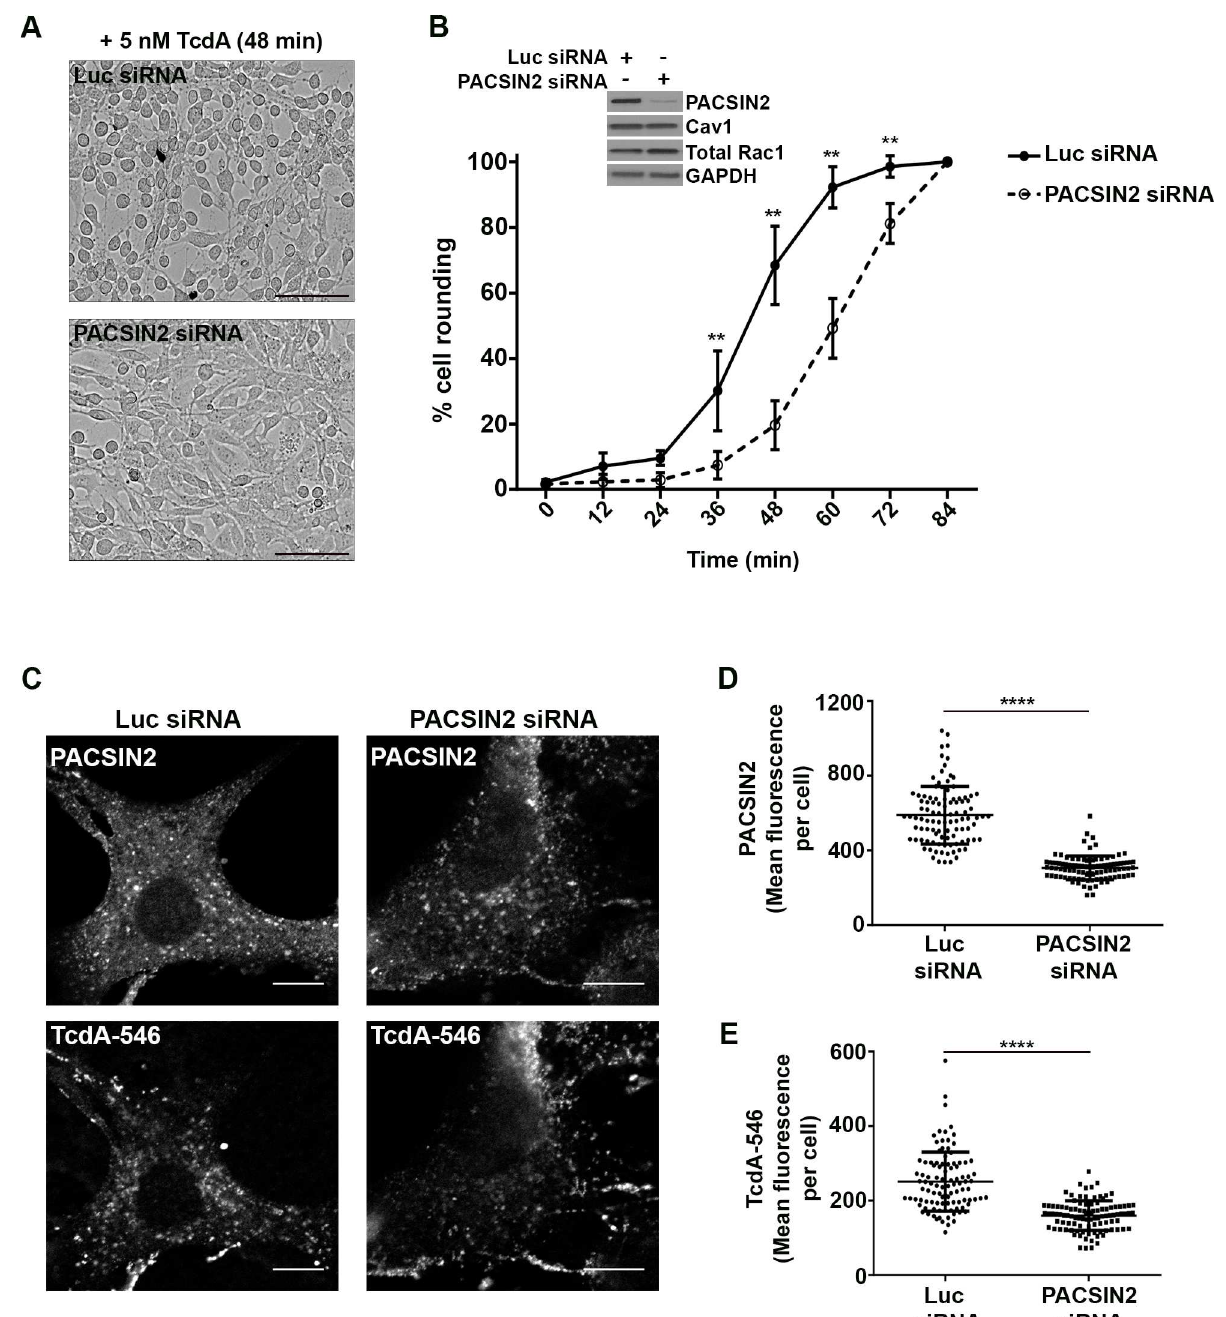
Fig 5. PACSIN2 is required for TcdA uptake and toxin-induced rounding in wildtype MEF cells. (A) and (B) Depletion of PACSIN2 delays TcdA-induced cell rounding in wildtype MEF cells. MEF cells transfected with luciferase (non-targeting) or PACSIN2 siRNA were challengedwith 5 nM TcdA, and toxin-induced cell roundingeffects were monitoredusing an imaging-based kinetic assay as describedin Materials and Methods. Representative images of cells 48 min post-toxin treatment are shown in (A) . Scale bars, 100 μ m. (B) The percentage of roundedcells in each siRNA conditionwas quantified for the indicatedtime points. Data represent mean and SD of at least 1200 cells from three independentexperiments. Data were analyzedusing two-way ANOVA and p-valueswere generatedusing Sidak’smultiple comparisons test in GraphPad Prism. ** p < 0.005.Western blots of wholecell lysates shown in inset indicatethat PACSIN2 siRNA transfection resulted in a significantdecrease(96.3 ± 2.8%) in PACSIN2 protein levels but did not affect Cav1 or Rac1 levels in cells. (C), (D) and (E). Depletion of PACSIN2 reduces TcdA uptake in MEF cells. Wildtype MEF cells expressing luciferase (luc) or PACSIN2 siRNA were incubatedwith 50 nM TcdA-546 at 10˚C for 45 min. Cells were allowedto warm up to 37˚C for 2 min and then